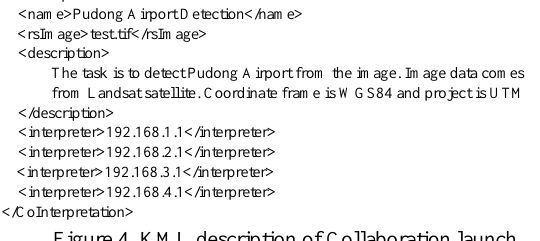
Figure 2. Collaboration mode